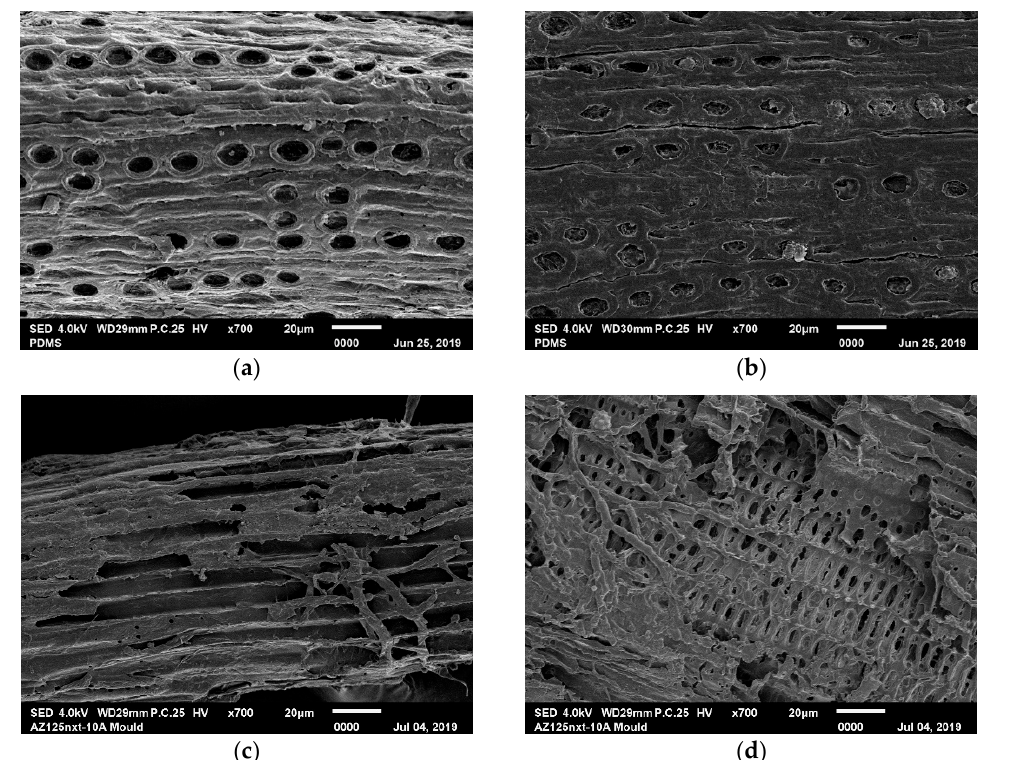
Figure 7. S EM images showing degradation stages of EFB lignin under continuous exposure to P. chrysosporium in PDB electrolyte: ( a ) day 0; ( b ) day 10; ( c ) day 20; ( d ) day